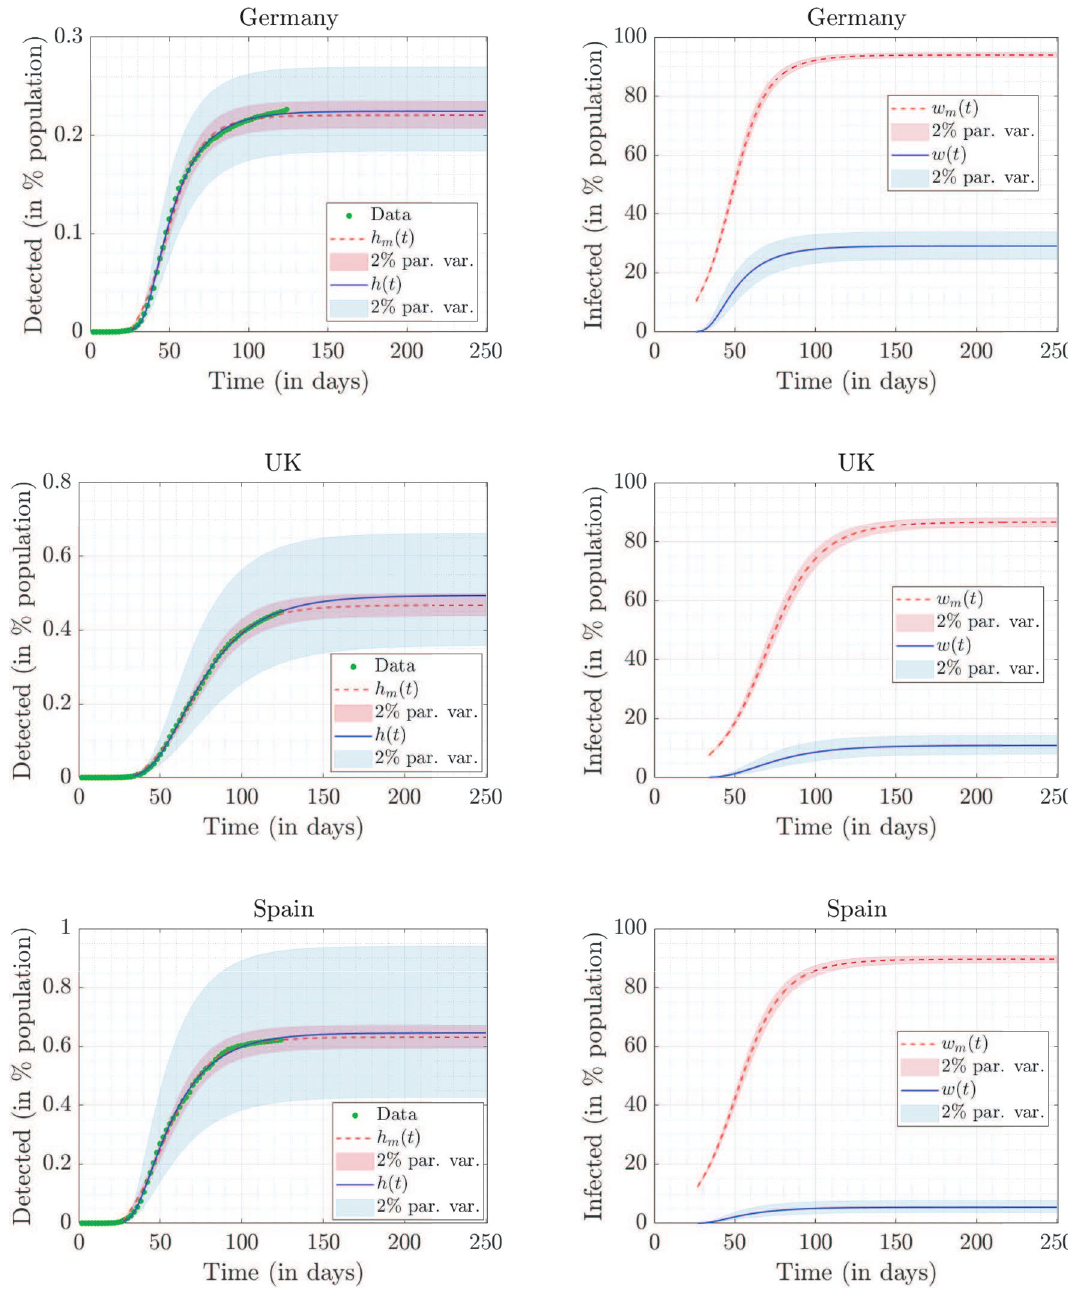
Figure 1. A correct version of the original Figure